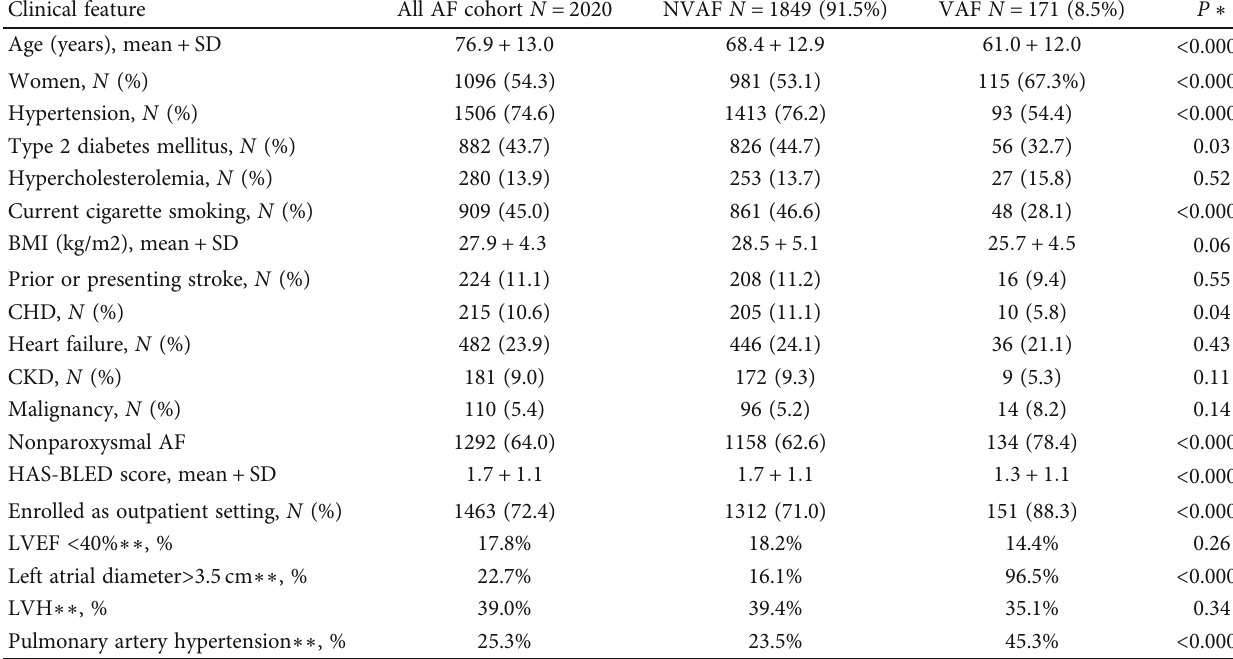
Table 1: Baseline demographic, clinical, and echocardiography characteristics of 2020 patients with AF and two subgroups of NVAF and